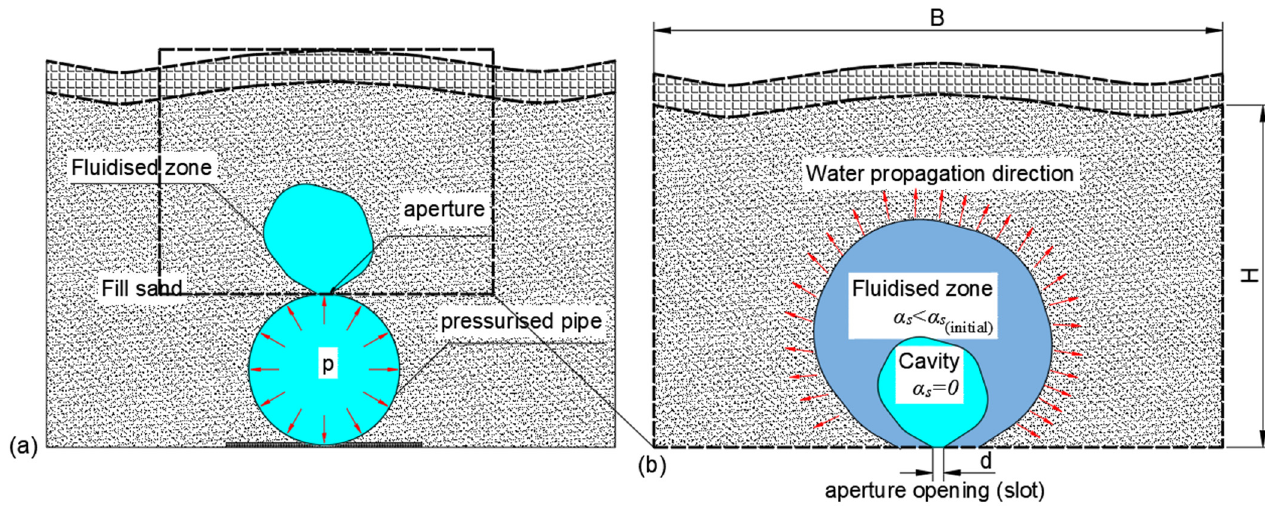
Figure 2. Schematic diagrams of soil fluidization in the vicinity of a leaking pressure pipe: ( a ) illustration of the formation of internal fluidization; ( b ) a conceptual representation of the fluidization parameters around the aperture.